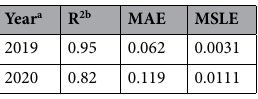
Table 2. Ruminal degradation curve fit to full season P. annua emergence and cooling degree day accumulation data collected at East Tennessee AgResearch and Education Center—Plant Sciences Unit (ETREC) (Knoxville, TN) in 2019 and 2020. Emergence was monitored on a weekly basis in plots (1 m 2 ) established as a hybrid bermudagrass ( C. dactylon L. Pers. x C. transvaalensis Burtt-Davy, cv. ‘Tifway’) fairway and maintained as bare soil. a Yearly cumulative P. annua emergence data and cooling degree days (CDD 21C ) accumulation data were fit to the following ruminal degradation function: Emergence (%) = − 0.01275 + 0.9220 + (1 − exp(− 0.004 × CDD 21C )). b Model fit was assessed using coefficient of determination (R 2 ), mean absolute error (MAE), and mean squared log